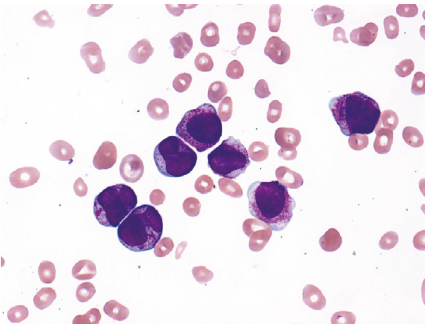
Figure 1: Peripheral blood smear demonstrating many primitive cells with round and lobated nuclei and moderately abundant cytoplasm with numerous cytoplasmic granules. Auer rods were readily identified; some cells had multiple Auer rods. A classic appearance for